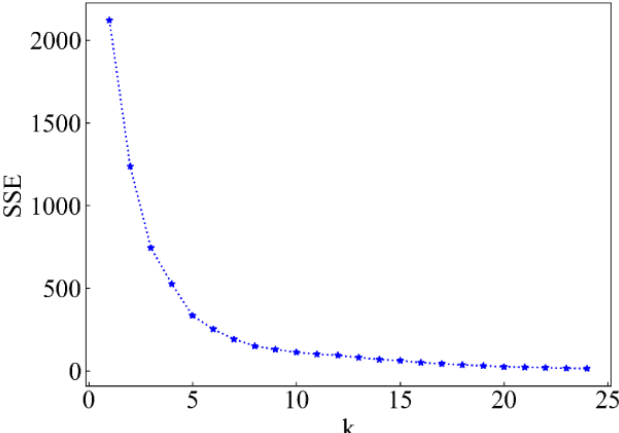
Figure 7. The relationship between SSE and the number of classes for R4.